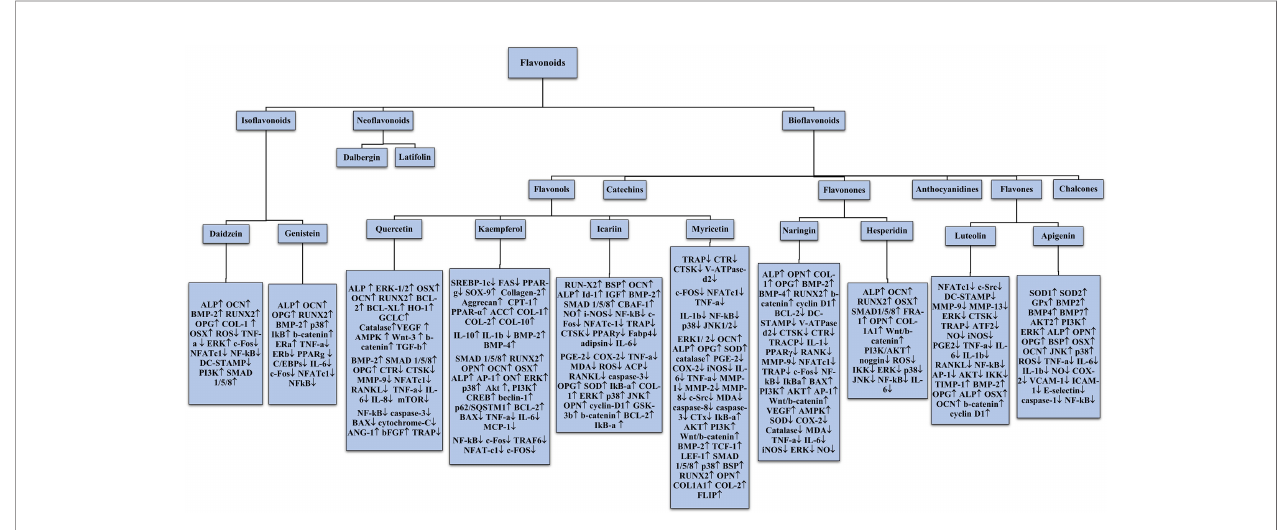
FIGURE 9 | Overall schematic depiction of fl avonoids regulating molecules in bone remodelling.